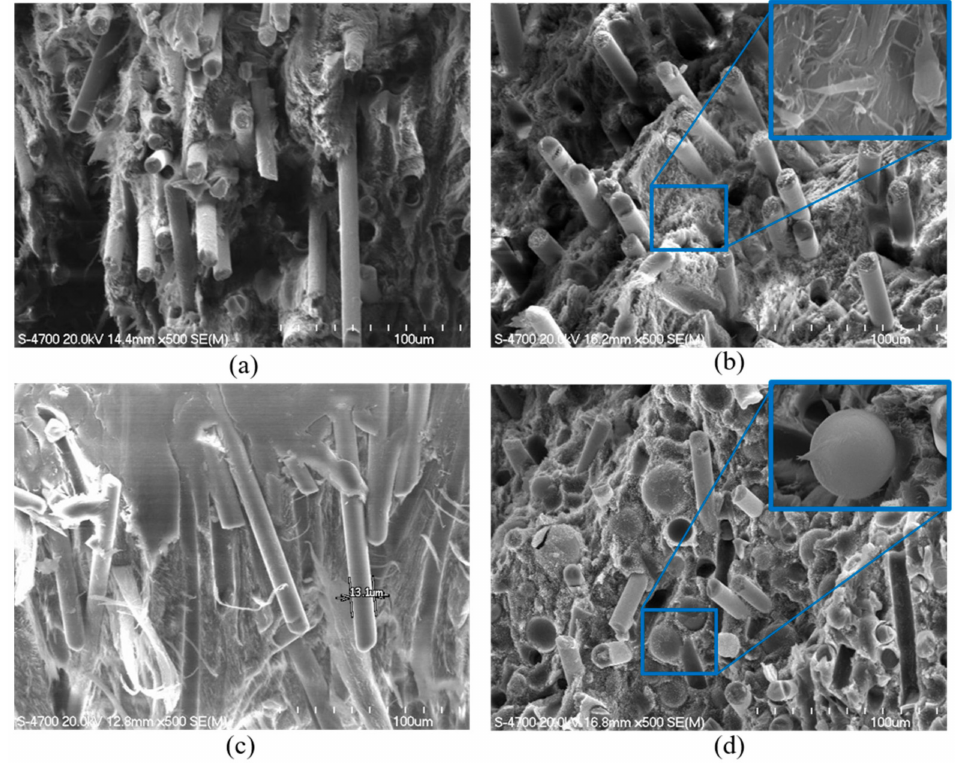
Figure 6. Cross-sectional SEM images of the LCP composites: ( a ) LCP, ( b ) LCP_sepiolite 5 wt%, ( c